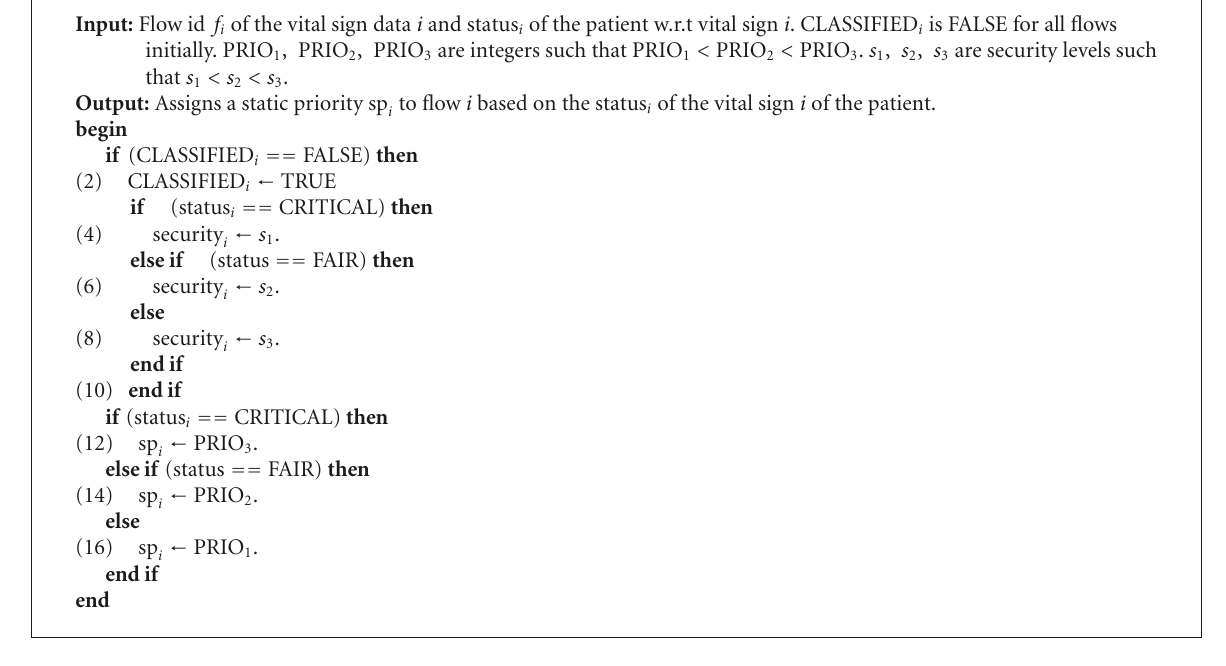
Algorithm 2: Procedure CLASSIFY.